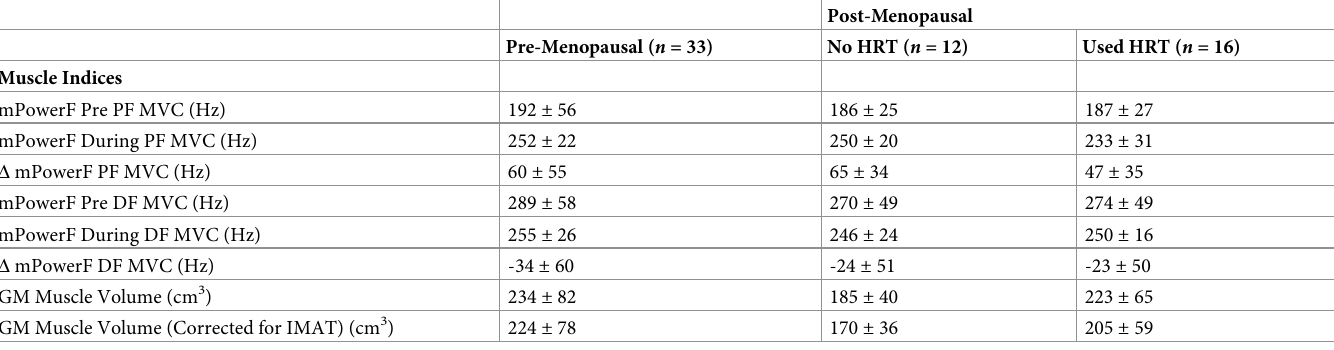
Table 4. Descriptive muscle indices grouped by menopause phase and use of hormone replacement therapy (HRT).